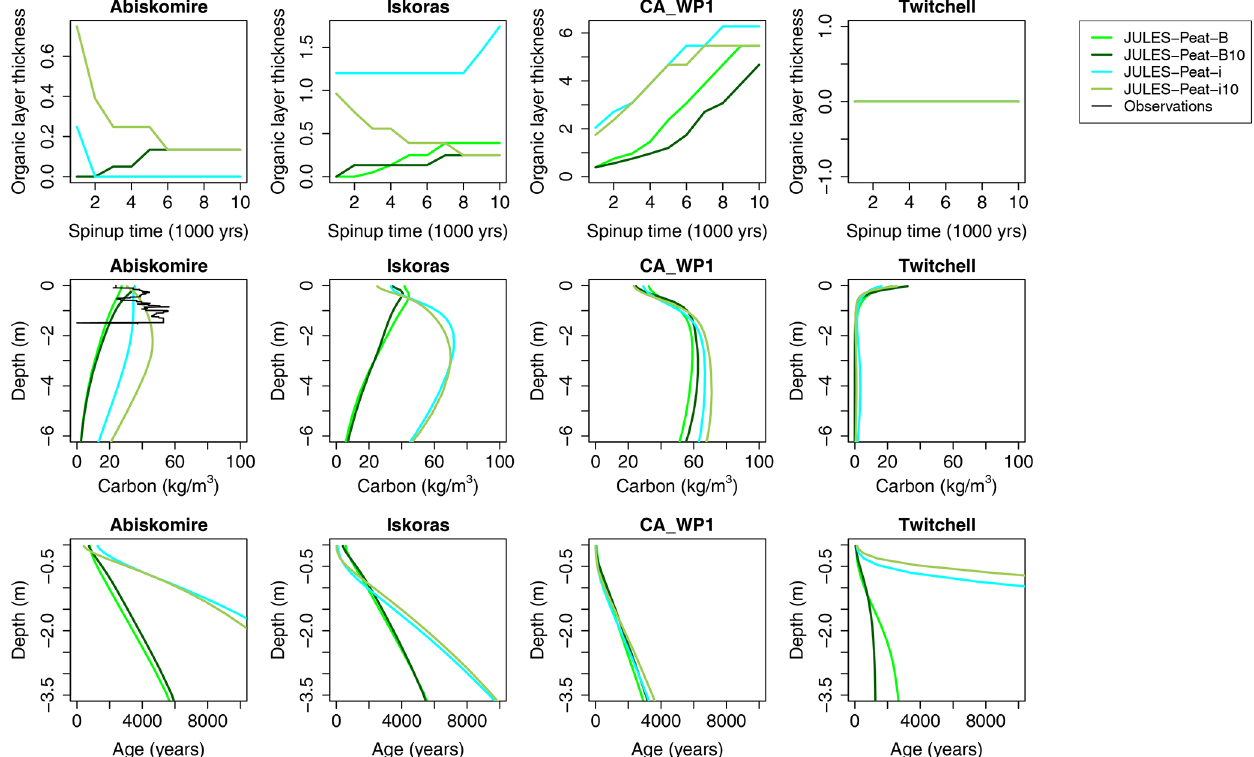
Figure 11. Demonstration of how peat accumulation rate can depend on initial conditions. Profiles of carbon and age are shown at the end of spin-up. Note that the ages below a certain depth at Twitchell are not relevant due to the carbon pools being almost zero. Note also that the spin-up time is given in thousands of years (so the total spin-up period is 10000